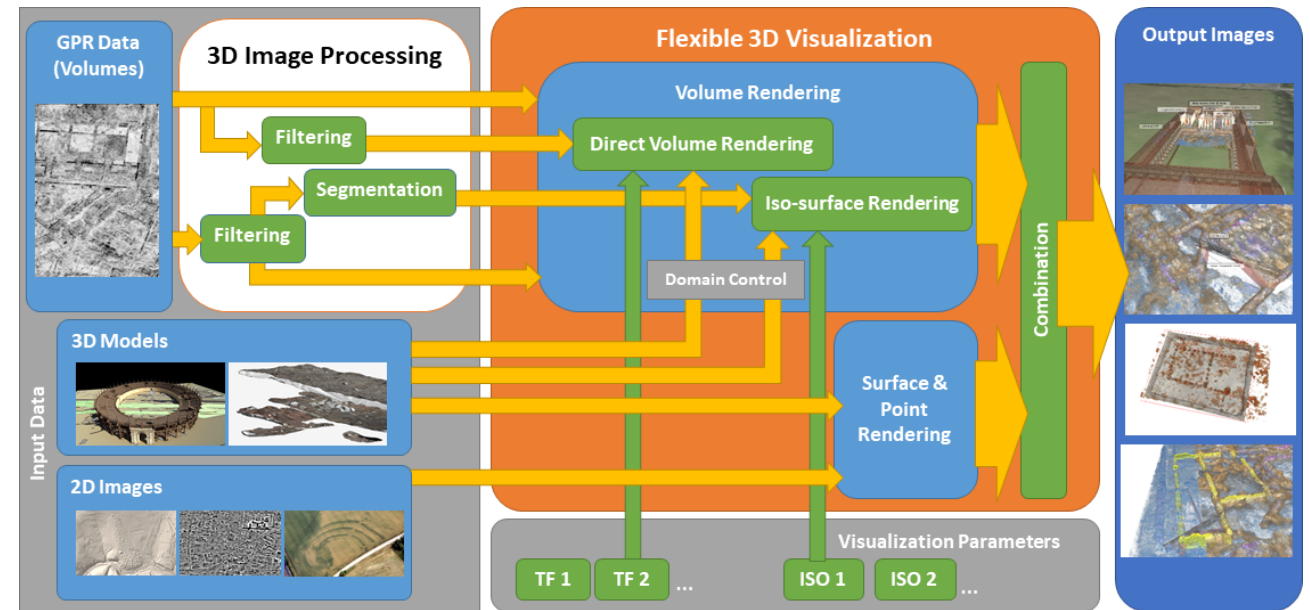
Figure 3. Visualization system overview: The system supports a wide range of data types. The 3D volumes may be visualized using DVR or as iso-surface, directly or after undergoing 3D image processing. The flexible visualization algorithm supports combining multiple datasets, or multiple versions of the same dataset by combining all their visual contributions. Furthermore, contributions from 3D models and 2D imagery are integrated. The 3D models can be used to control the visible portions of volume datasets, as well as the application domains of transfer